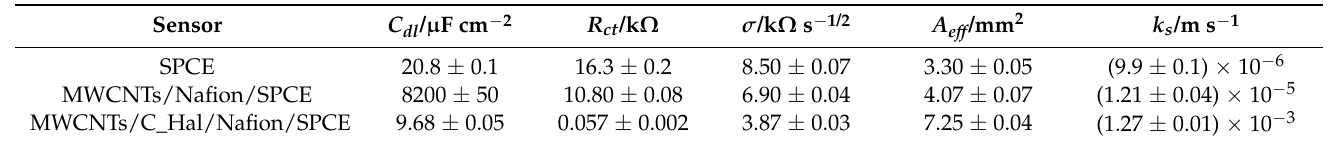
Table 2. The comparison of electrochemical characteristics of tested electrodes based on parameters achieved from EIS measurements ( n =